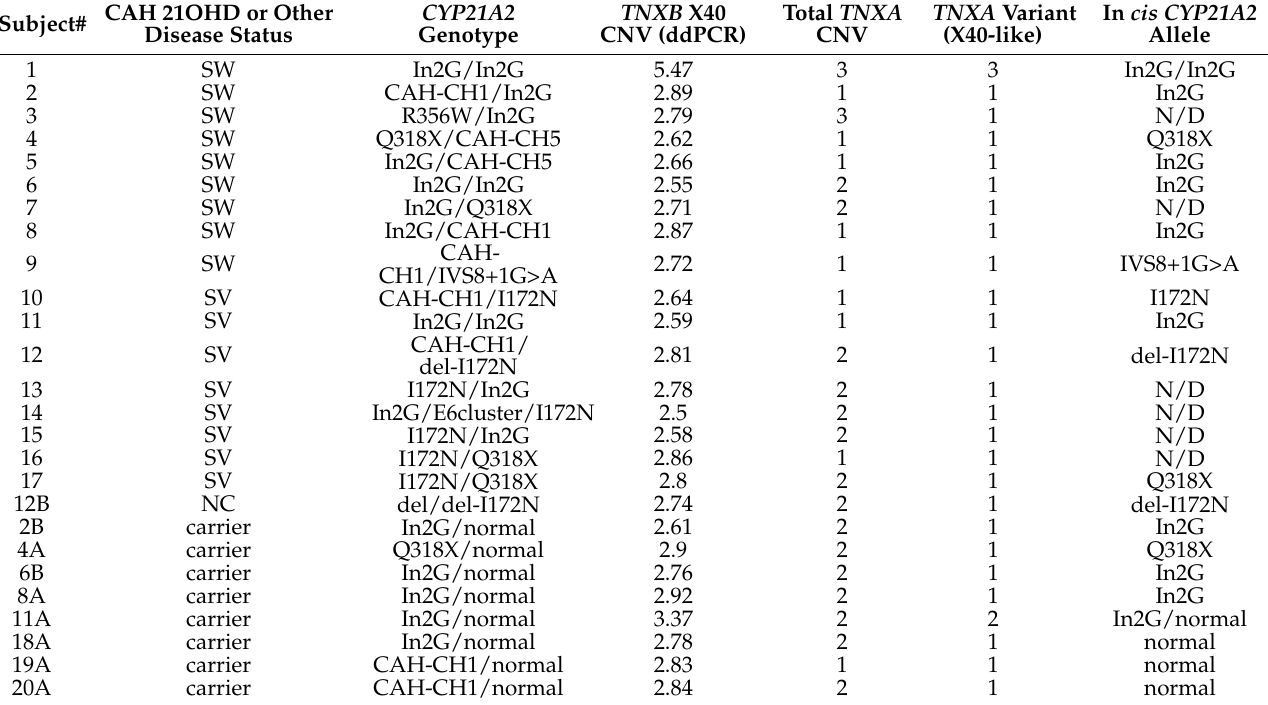
Table 1. TNXB -like TNXA variant alleles in subjects with excessive TNXB exon 40 copy